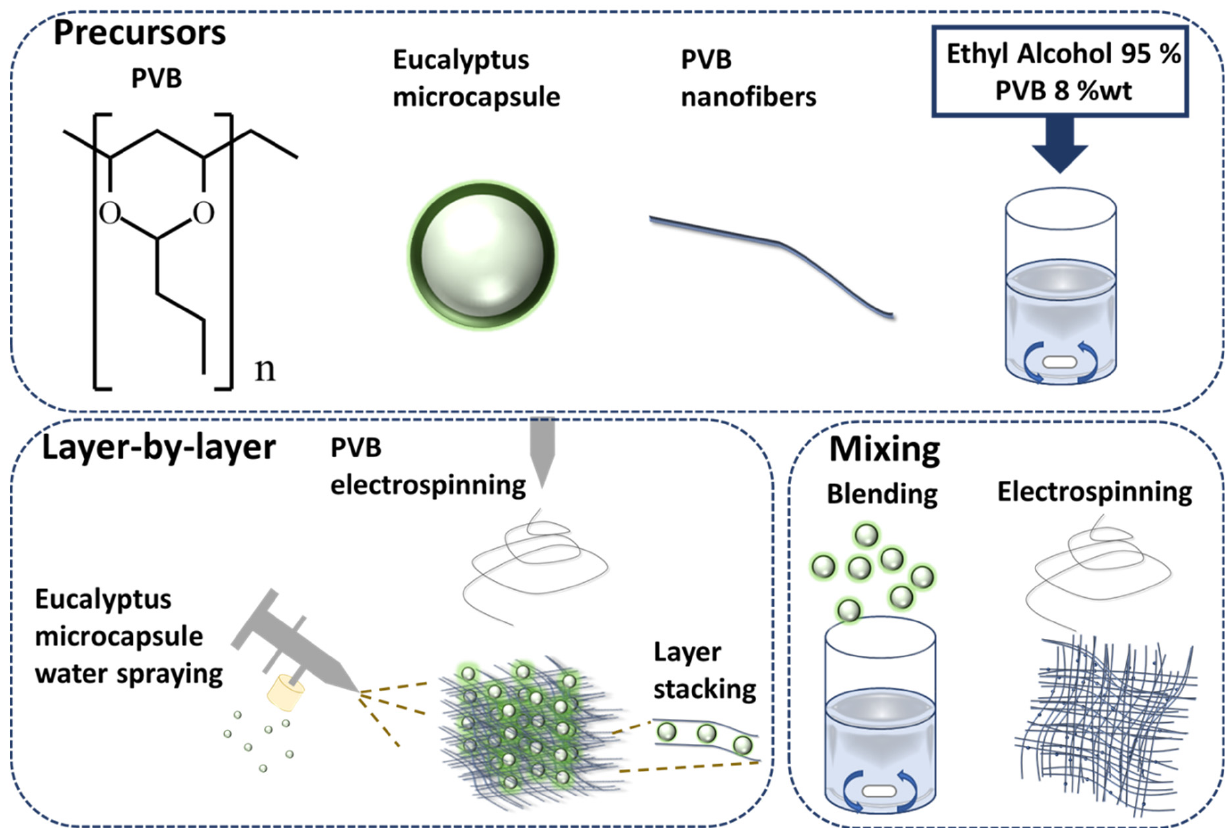
Figure 1. Mixing and layer-by-layer nanofibers fabric are fabricated as shown above. First, PVB is dissolved into ethyl alcohol. Second, via layer-by-layer approach, water-dissolved eucalyptus microcapsules are sprayed between PVB fibers stacking. Via mixing, eucalyptus microcapsules are mixed with PVB prior to electrospinning.